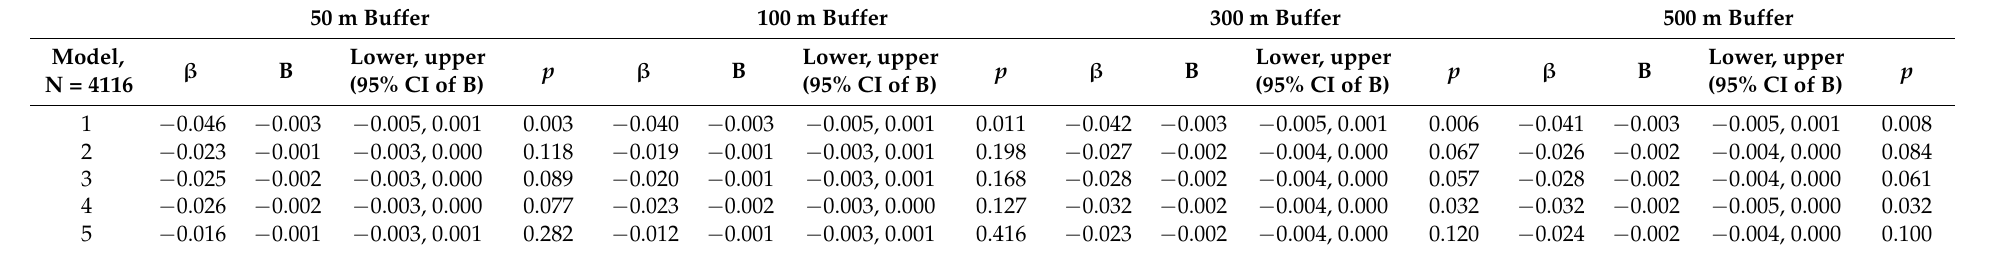
Table 5. Associations between residential greenspace at 50 m, 100 m, 300 m, and 500 m buffers, and burnout symptoms (subsample: non-working). 50 m